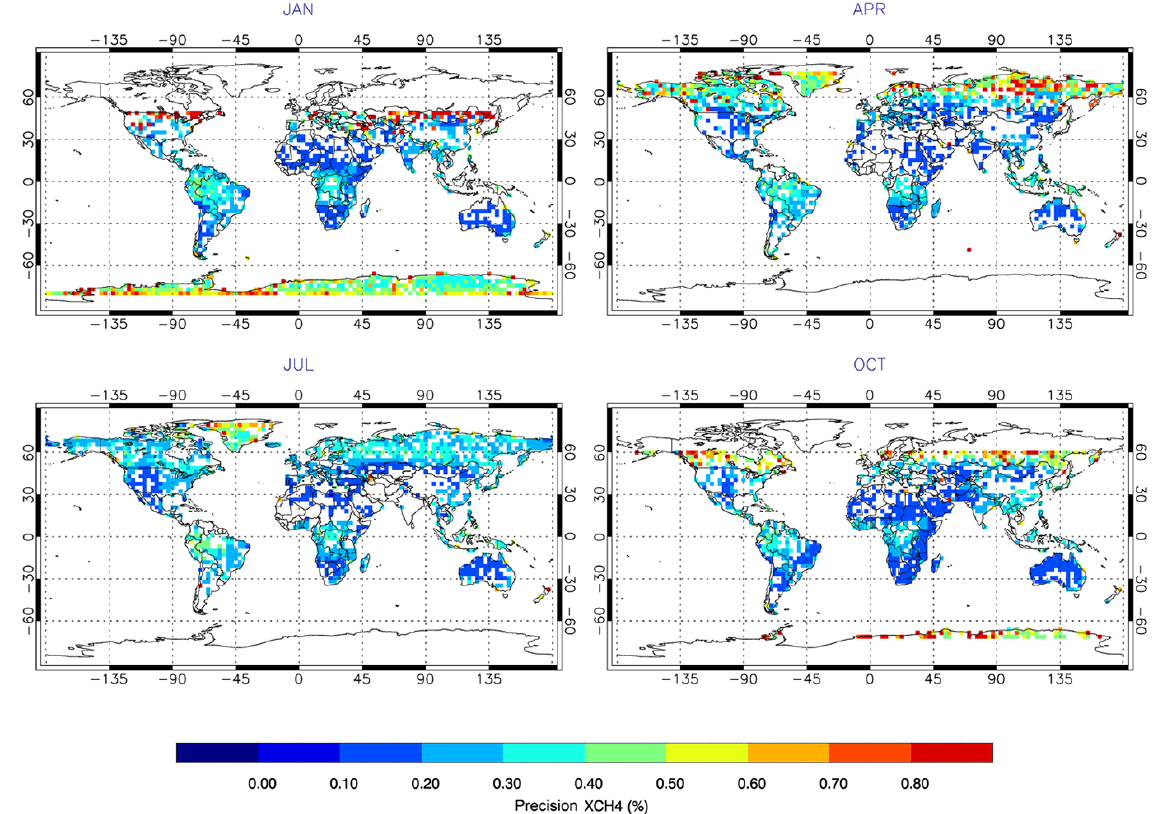
Figure 7. Relative precision of XCH 4 due to the instrument noise for the a posteriori filtered data set for the clear-sky ensemble in Fig. 4. Table 2. Effect of instrument calibration errors on convergence rate, fraction of valid retrievals after filtering and rms values of XCH 4 bias and precision for the global ensemble. Note that all sensitivities include the baseline forward model error, caused mainly by aerosol and cirrus scattering. The terms between brackets are for the cases where the relevant quantity is also retrieved. For each instrument calibration error, multiple simulation runs were performed with all combinations of errors in NIR and SWIR channels. The results shown here correspond to the runs with poorest performance in terms of the rms